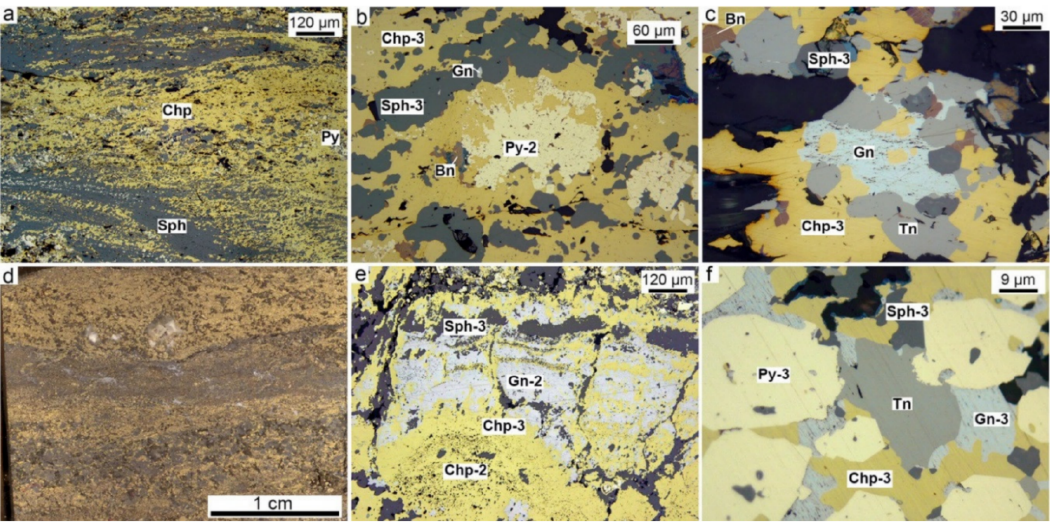
Figure 10. Mineralogical features of chalcopyrite-rich diagenites of the Valentorskoe ( a – c ) and Aleksandrinskoe ( d – f ) deposits: ( a ) Intercalation of chalcopyrite- and sphalerite-rich diagenites; ( b ) replacement of pyrite clasts by chalcopyrite, bornite and sphalerite; ( c ) galena–tennantite– sphalerite–bornite assemblage in chalcopyrite (black, quartz and chlorite); ( d ) alternation of chalcopyrite- and sphalerite-rich diagenites; ( e ) replacement of galena-2 by chalcopyrite-3 in pseudomorphic chalcopyrite-2 after colloform pyrite; ( f ) pyrite-3, galena-3 and tennantite in chalcopyrite-3. ( a , d ) Polished sample; ( b , c , e , f ) reflected